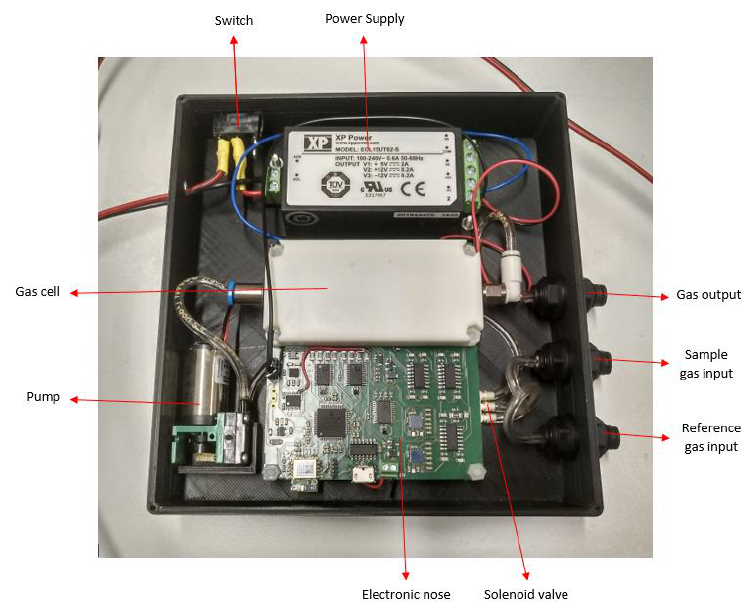
Figure 1. MultisensorNOSE top view.